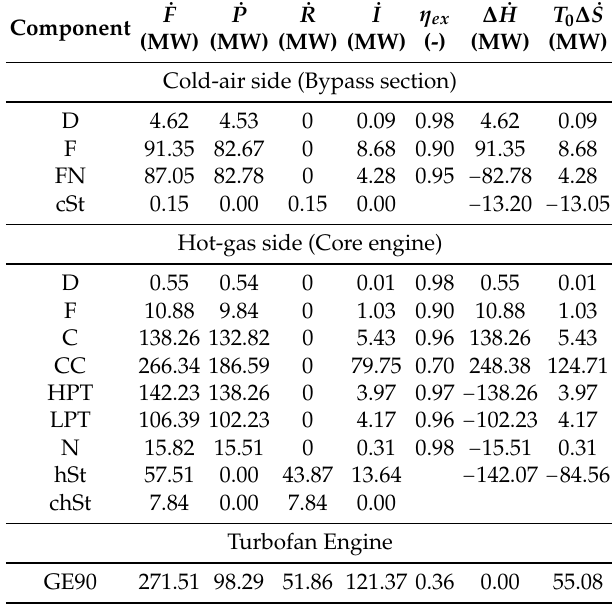
Table A2. Resources, products, residues, and irreversibilities of the turbofan components ( ˙ F = ˙ P + ˙ R + ˙ I ). ˙ Component